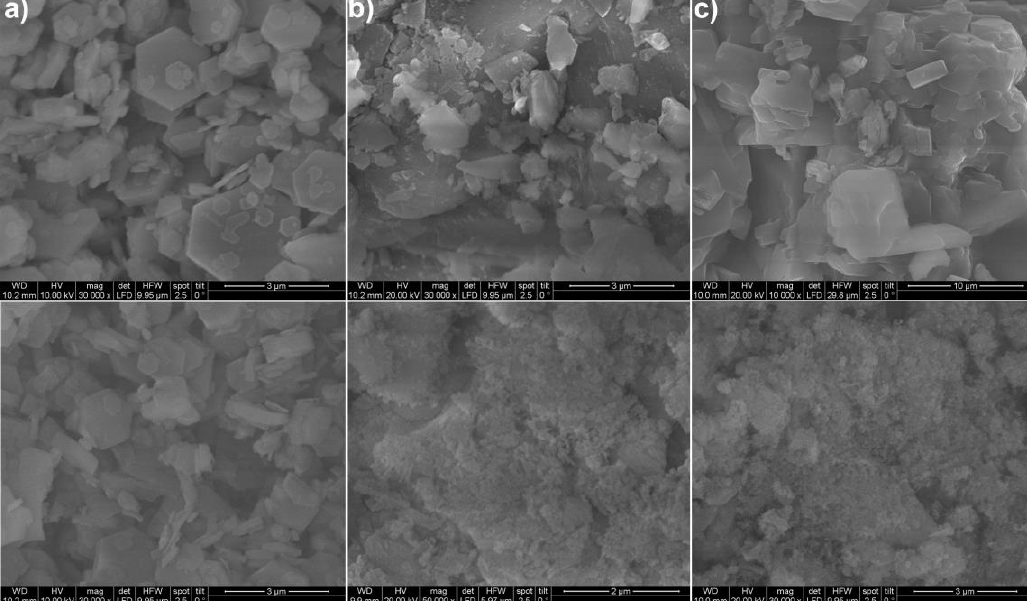
Figure 1. SEM pictures of ( a ) Mg(OH) 2 ; ( b ) MgCO 3 ; ( c ) MgC 2 O 4 ∙2H 2 O before calcination (first row) and after calcination (second